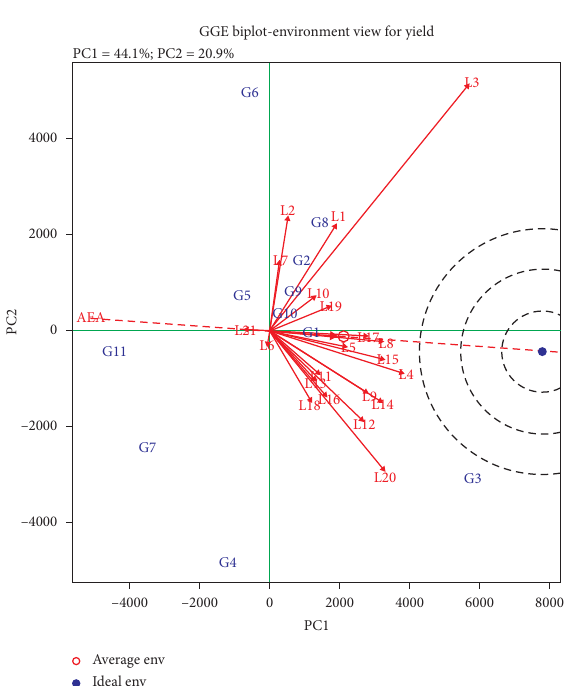
Figure 3: The vector view of GGE biplot showing the “discriminating power and representativeness” of the trial environments to assess maize hybrids under different cropping systems for rainy and dry seasons. The code of environments is given in Table 1. Code of genotypes is given in Table 2. PC, principal